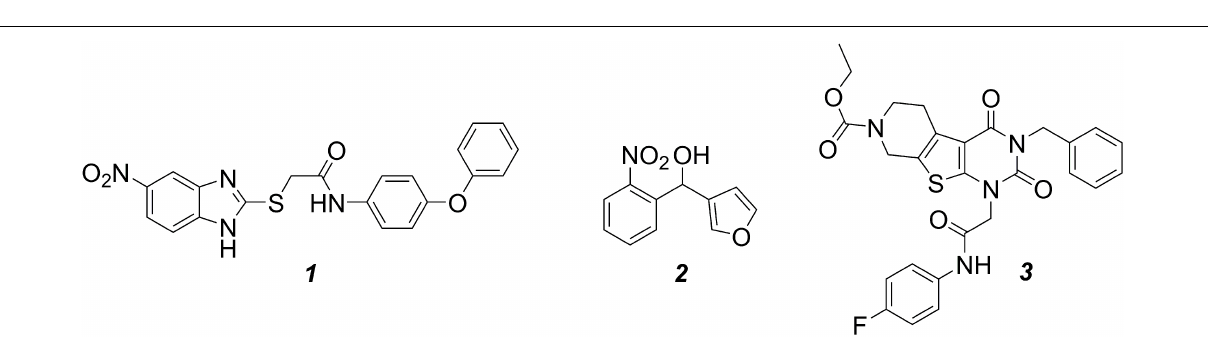
FIGURE 2 | Structures of the compounds evaluated in this work. MvfR antagonist 1 , PqsBC inhibitors 2 and 3